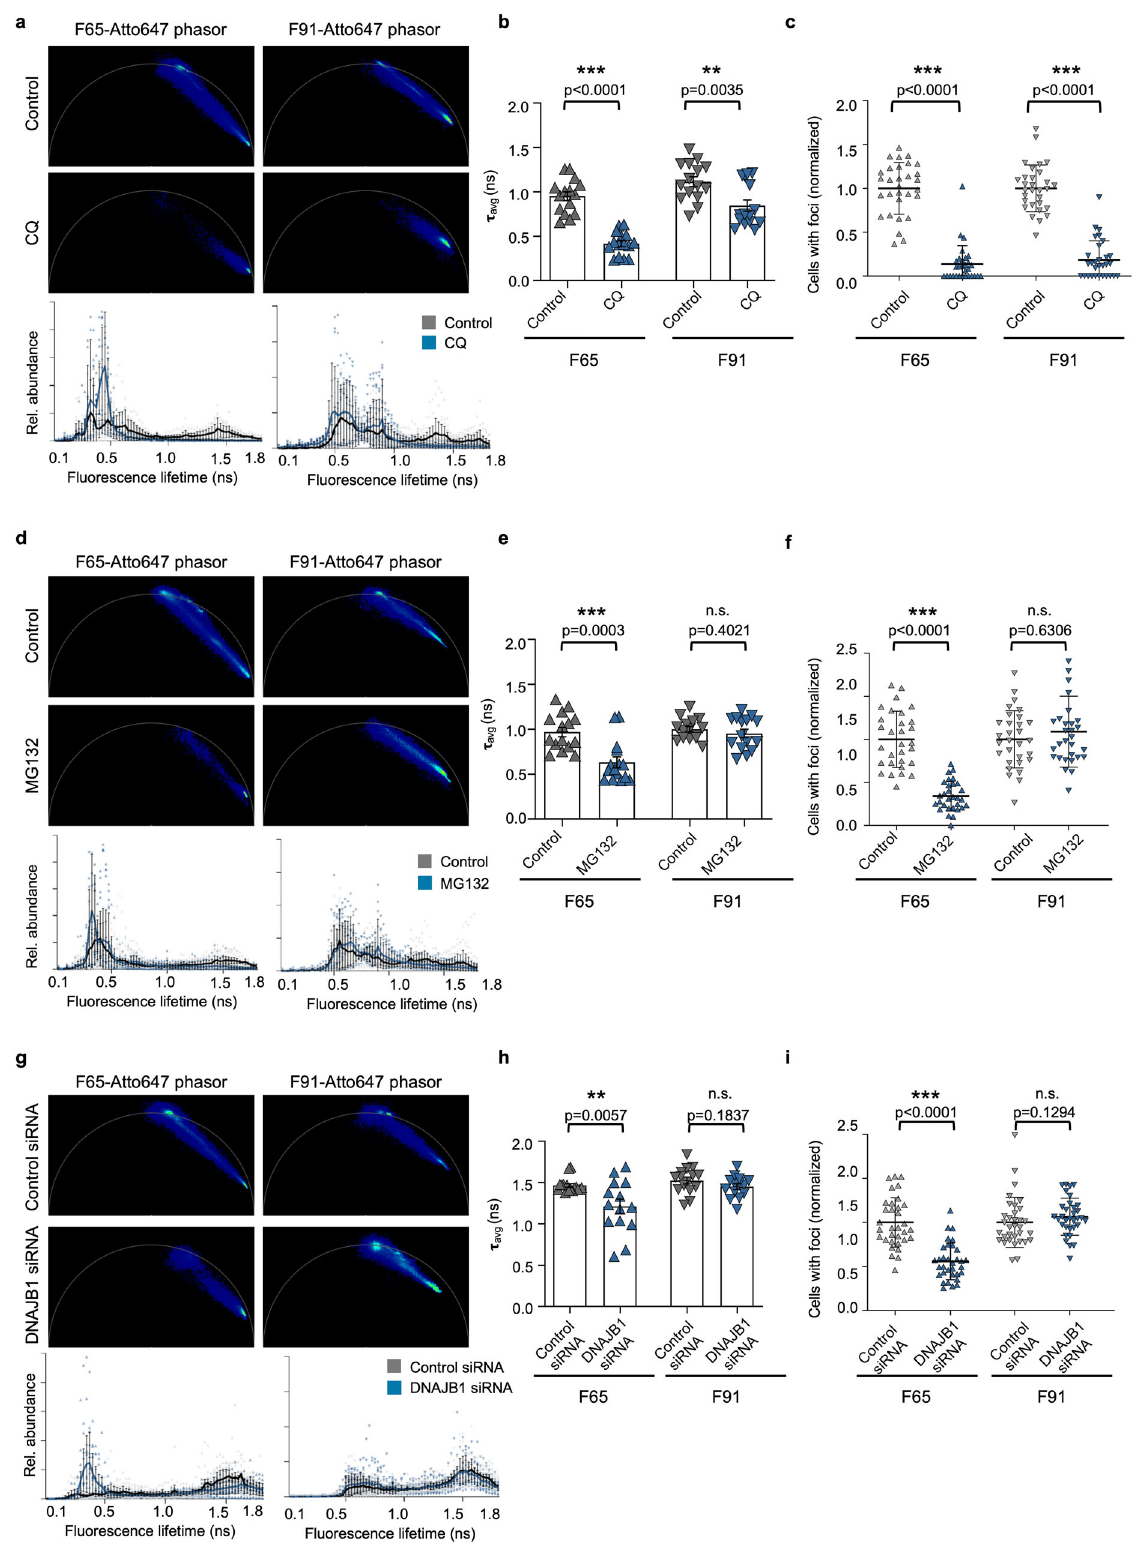
fl uorescence lifetime was also determined using FALCON FLIM (Leica) and was fi tted using bi-exponential decay. SDS-Page and immunoblotting . Cells were centrifuged to pellet followed by lysis in lysis buffer (10 mM Tris, 100mM NaCl, 0.2% Triton X-100, 10mM EDTA) on ice for 20 min. The lysates were transferred into fresh Eppendorf tubes and